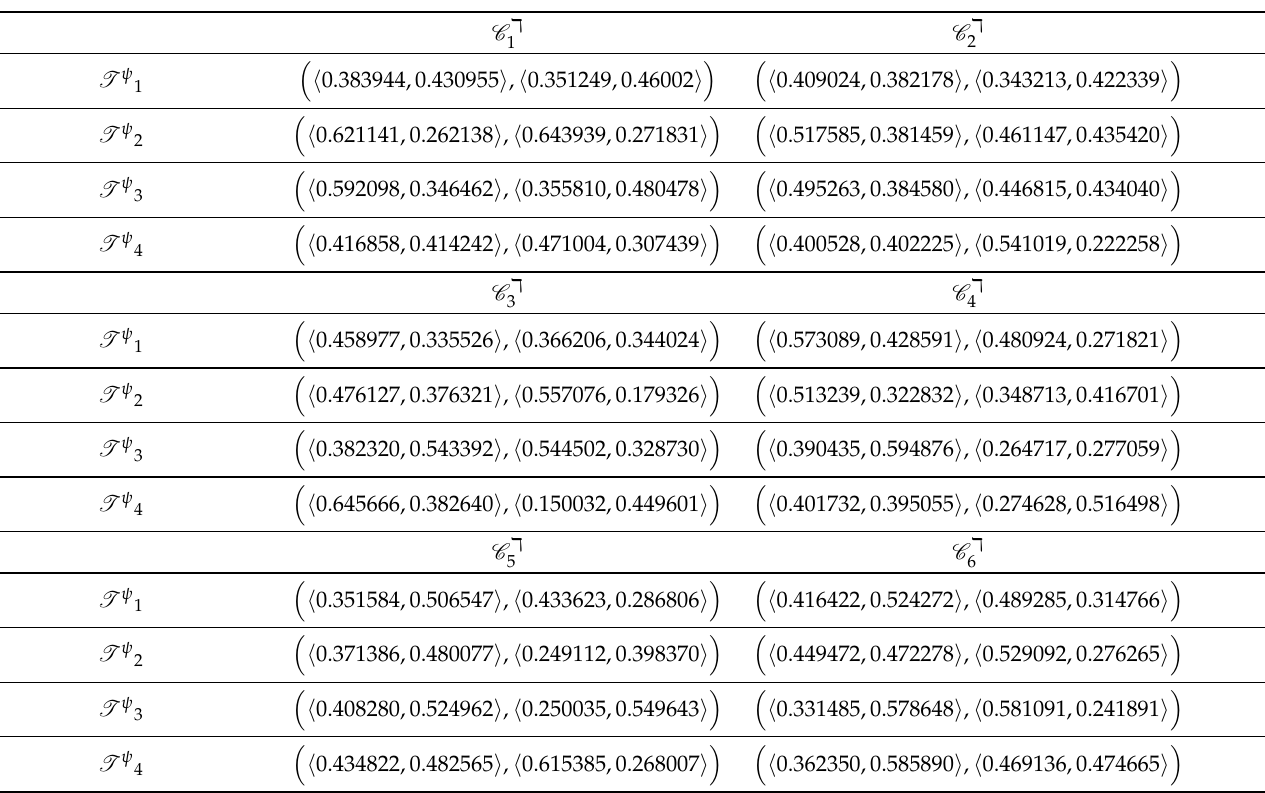
Table 8. Aggregated LDF decision